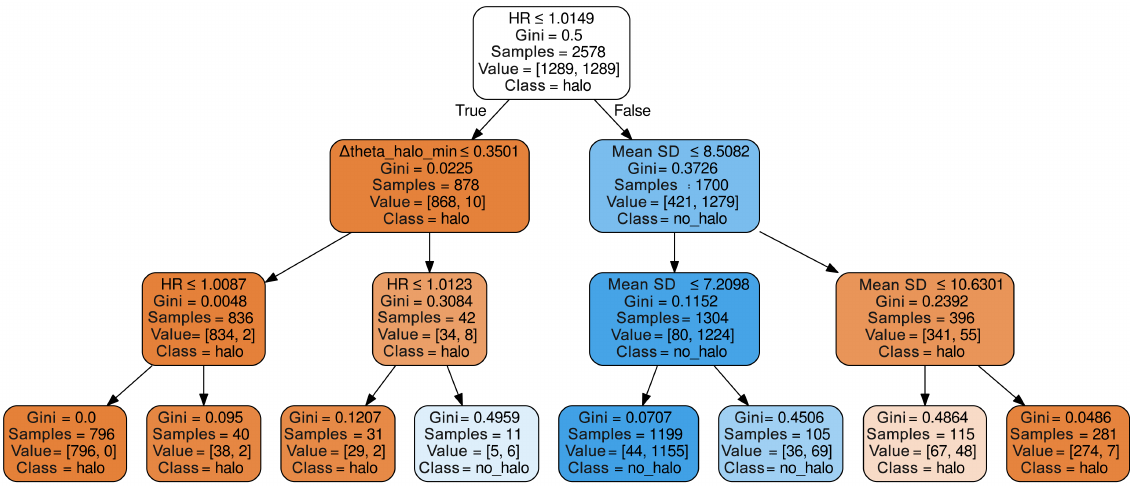
Figure A1. Example for a decision tree for a selection of three HaloCam image features confined to a maximum depth of three layers. The two classes, “halo” and “no halo”, are depicted by red and blue color. The transparency of the color represents the impurity of the class.